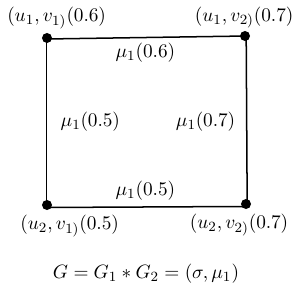
Figure 6. Strong fuzzy-graph Figure 6: Strong Fuzzy Graph Structure